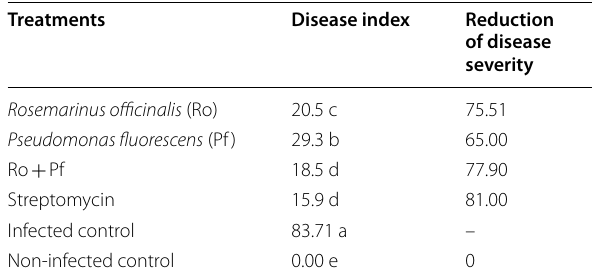
Table 3 Effect of Rosemarinus officinalis 1:10 w/v and Pseudomonas fluorescans 1 10 8 cfu/ml on severity of bacterial wilt disease of × tomato plants in greenhouse